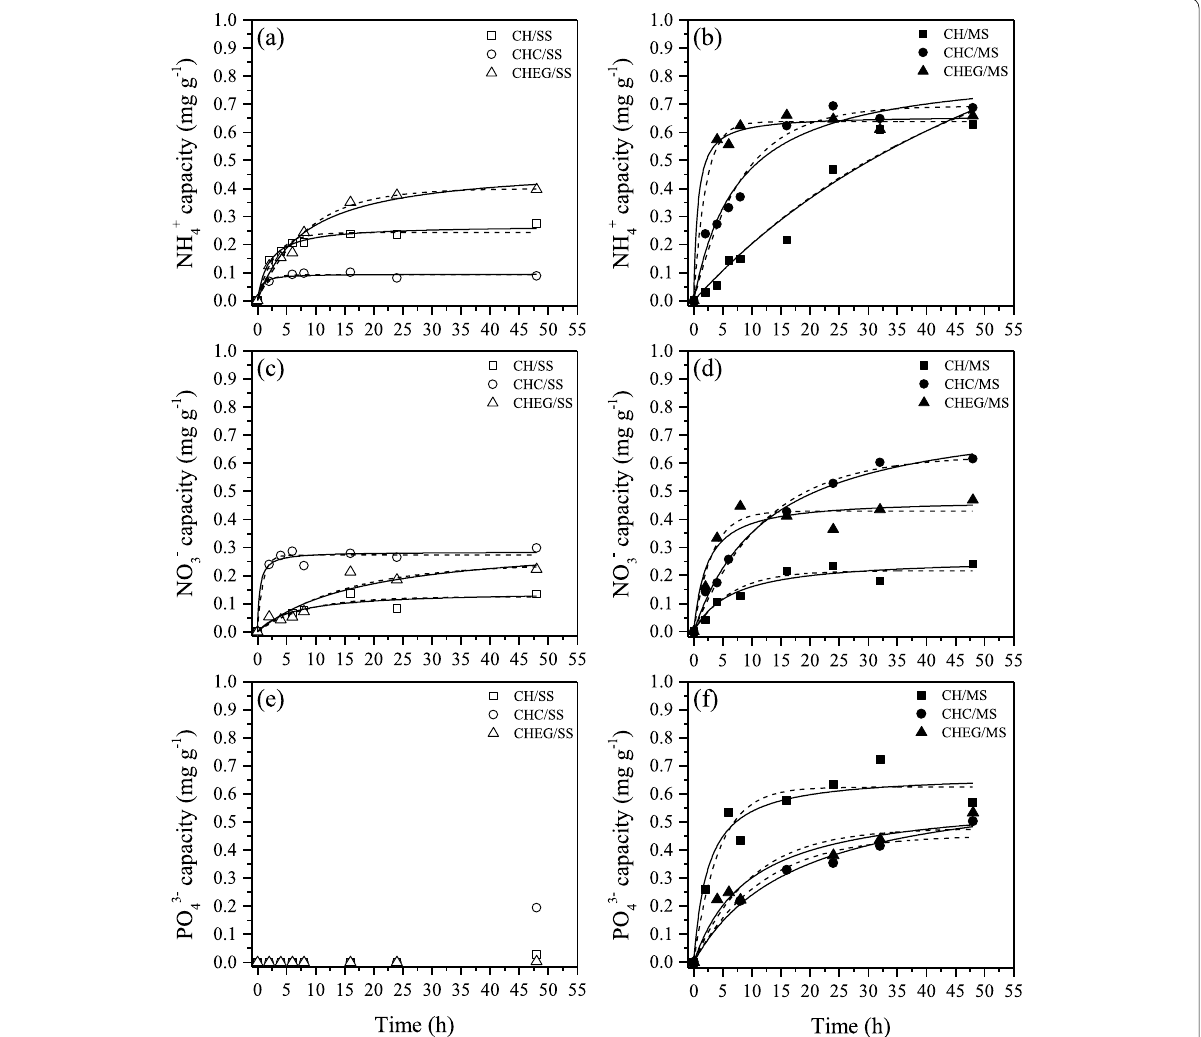
Fig. 5 Nutrient adsorption by 20 g L − 1 of CH, CHC, and CHEG; adsorption of ( a ) NH 4 + in single solute solution (SS); ( b ) NH 4 + in mixed solute solution (MS); ( c ) NO 3 − in SS; ( d ) NO 3 − in MS; ( e ) PO 43 − in SS; ( f ) PO 43 − in MS; dashed line line fitted with pseudo second order kinetics =